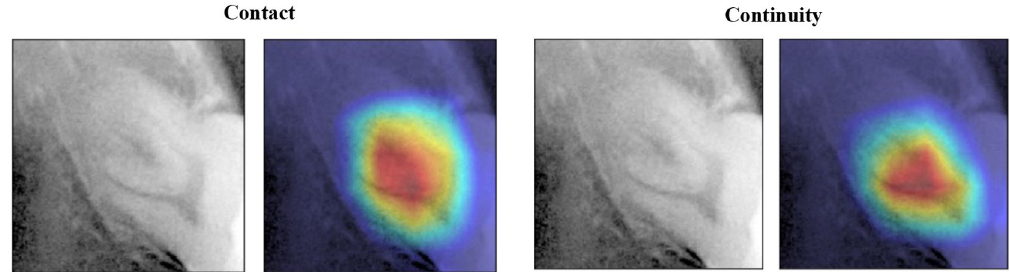
Figure 4. Visualization of regions of interest for CNN classification in contact and continuity